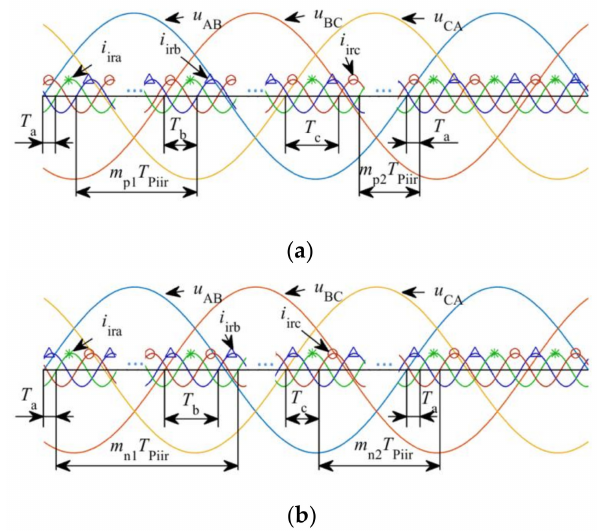
Figure 5. Injection of three-phase irregular currents. ( a ) Positive sequence irregular current; ( b ) Negative sequence irregular